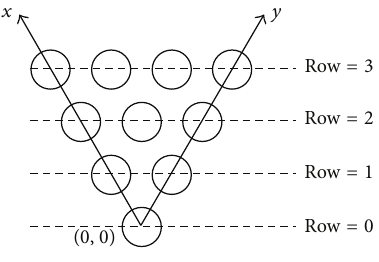
Figure 12: Parameter row.